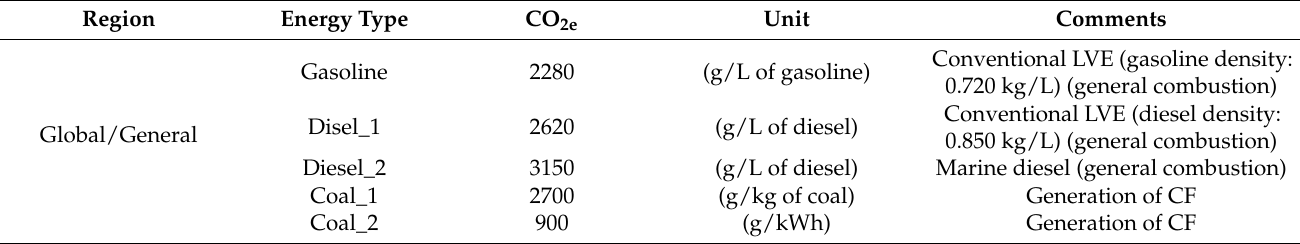
Table 12. GHGs emitted by different sorts of fuel used during the overall product life management [57,59,60].